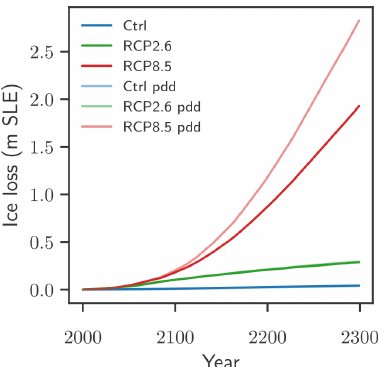
Figure D3. Comparison with the positive-degree-day model. PISM- dEBM-simple and PISM-PDD simulations of the Greenland Ice Sheet with RCP2.6 (green lines) and RCP8.5 (red lines) warm- ing. Ice loss is given in metres of sea level equivalent. A value of 1ms.l.e. corresponds to approx. 361800Gt of